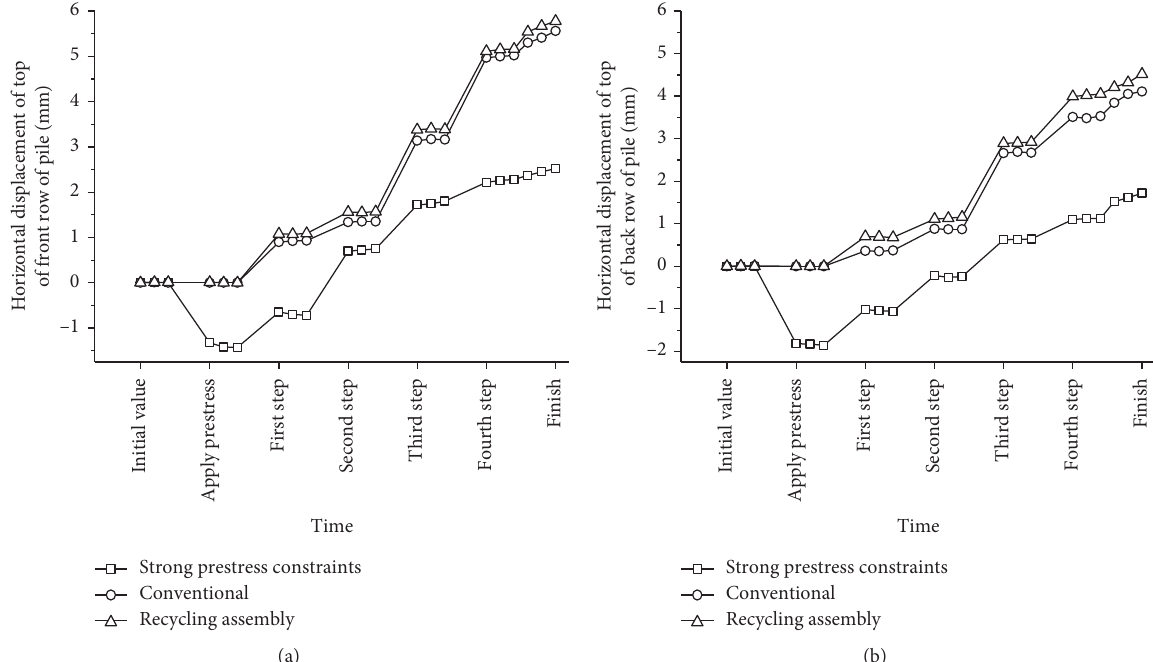
Figure 15: Comparison of horizontal displacement time history of pile top. (a) Front row pile. (b) Rear row